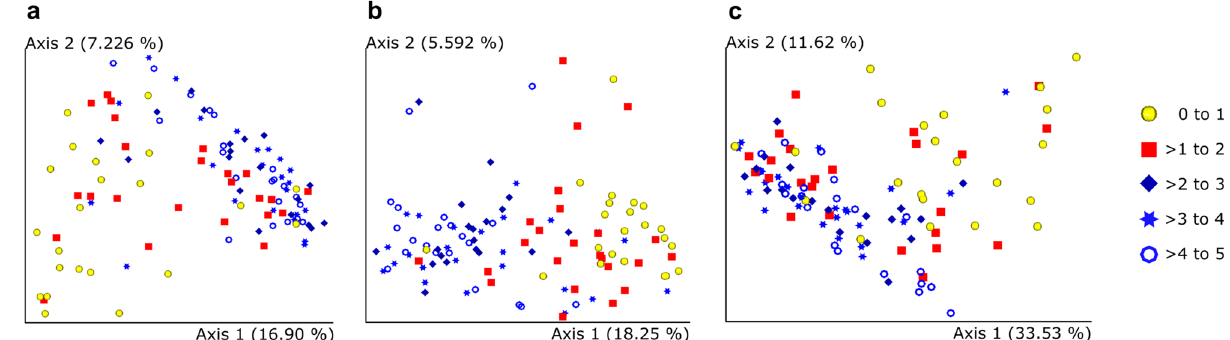
Figure 4. Two-dimensional PCoA plots based on three dissimilarity metrics. The three age groups are shown by colour. Yellow = A (0–1); Red = B (> 1 to 2); Blue = C (> 2 to 5). Group C is further subcategorized by